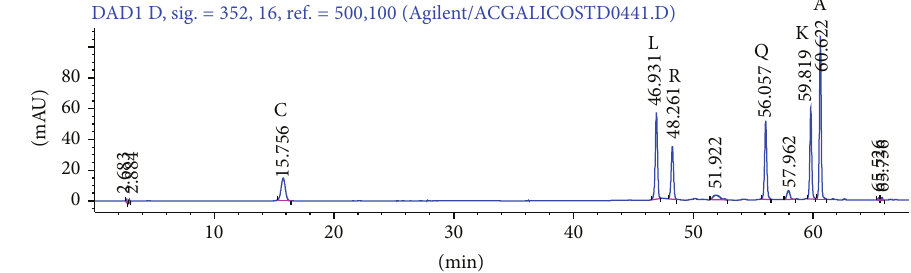
Figure 1: Chromatogram of a mixture of standards’ polyphenols; DAD detection is at 352 nm. The chromatographic conditions are described in the text. Peak identification: C: chlorogenic acid; L: luteolin; R: rutin; Q: quercetin; K: kaempferol; A: apigenin.